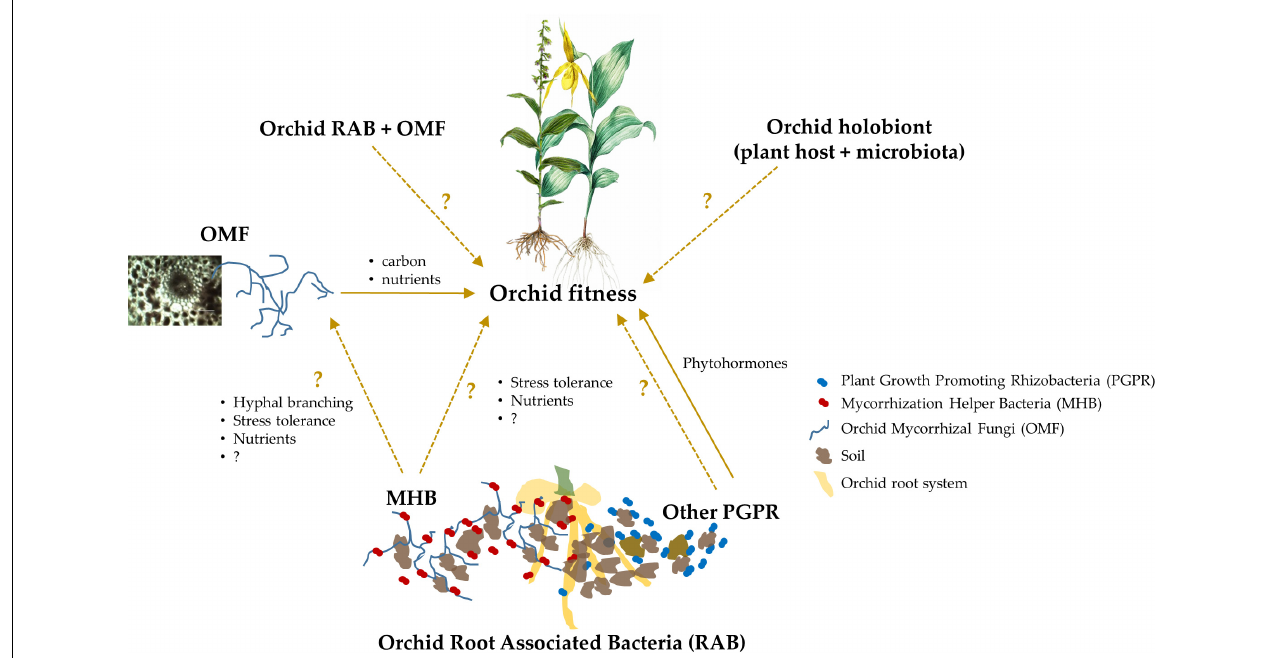
FIGURE 1 | A schematic representation of the known and putative effects of orchid Root Associated Bacteria (RAB) on plant fitness, which eventually governs species ecology and evolution. Some orchid RAB are known to enhance plant fitness as Plant Growth Promoting Rhizobacteria (PGPR), and although currently unknown, they also may confer beneficial effects by helping Orchid Mycorrhizal Fungi (OMF) as Mycorrhization Helper Bacteria (MHB). The coupling of orchid RAB and OMF, and a combination of the host orchid and its microbiota (i.e., the orchid holobiont) likely also influence plant fitness, but these mechanisms are currently unknown in orchids. In the schematic, the unknown or underexplored interactions or effects are represented with dashed arrows and questions marks, while the known effects are represented with solid